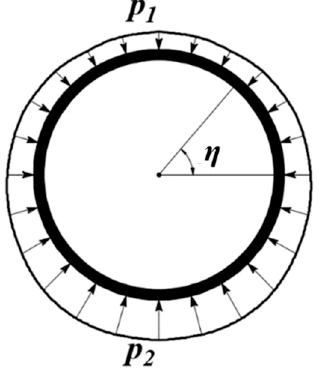
Figure 4. Initial shield shell force calculation model.